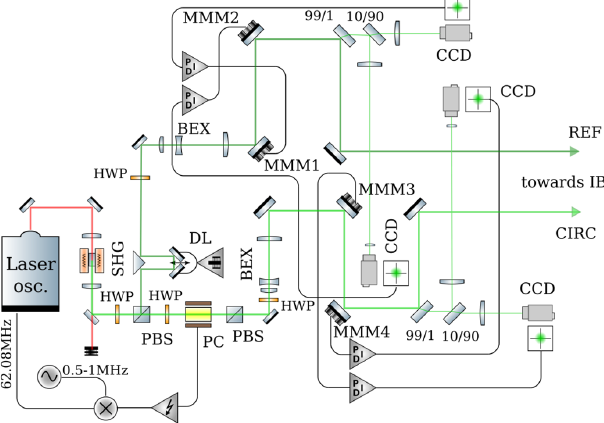
FIG. 13. Optical scheme of the synchronization and alignment laser-beam tool. SHG: second harmonic generator; HWP: half wave retardation plate; DL: piezo-electric motorized delay line; PBS: Polarizer beamsplitter; PC: Pockels Cell with half wave phase retardation. BEX: beam expander; MMMX: piezo-electric motorized steering mirror mount; CCD: charge coupled device based area detector allowing for laser-beam spot centroid determination; PID: Proportional Integrate Derivative software controllers for the closed loop control of the beams positions and